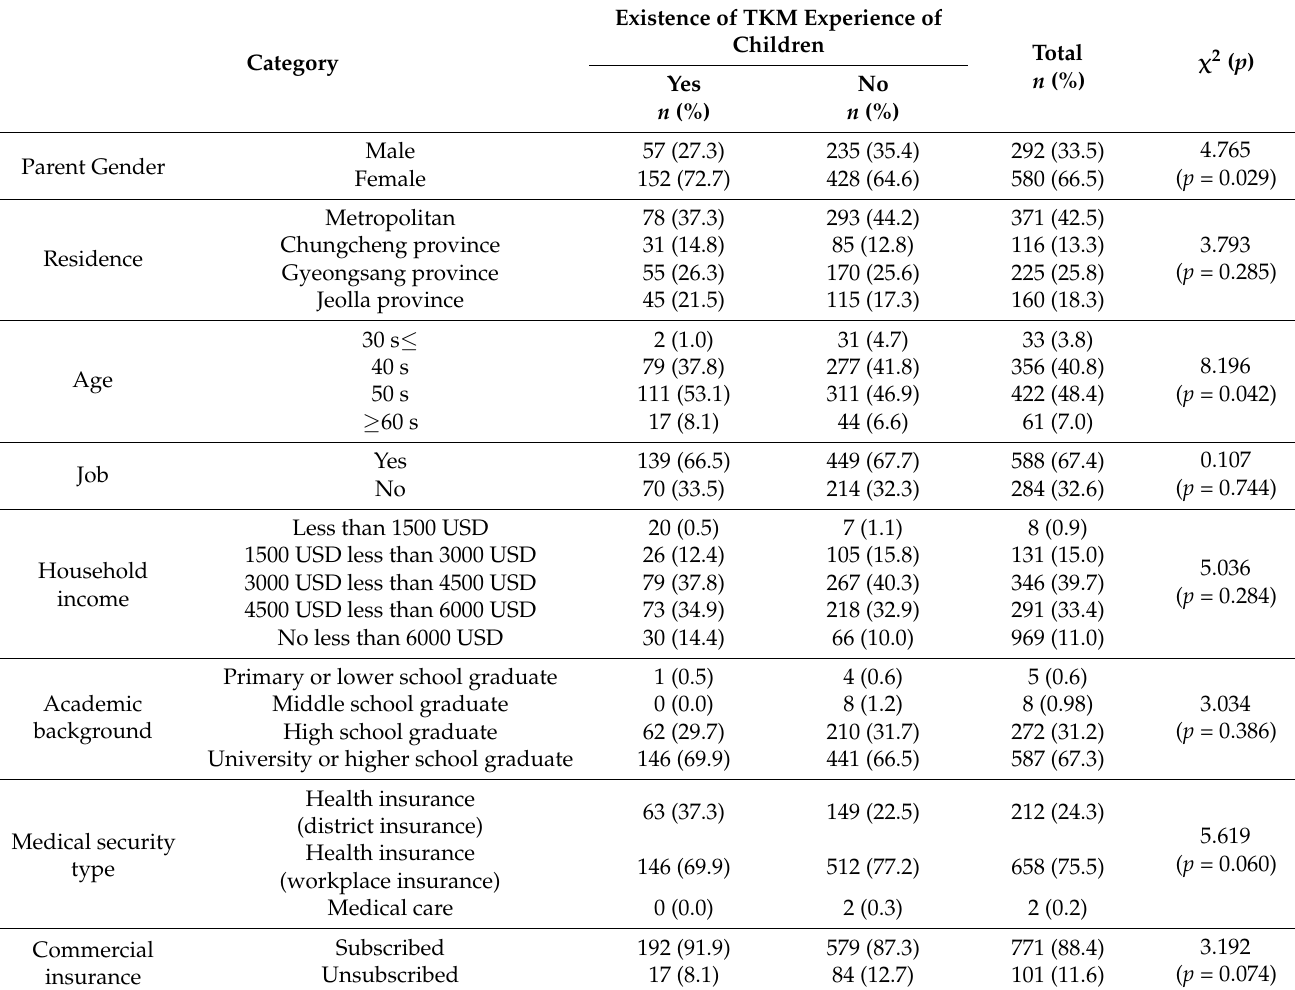
Table 2. Characteristics of the study population from the survey with and without traditional Korean medicine (TKM) experience of